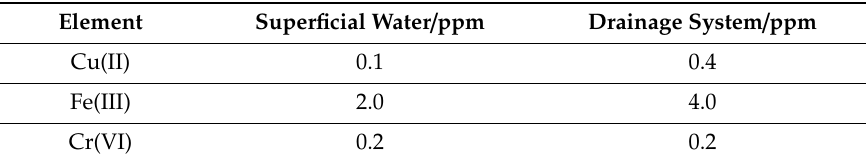
Table 3. Italian legal concentration limit for chromium (VI), iron, and copper for disposal in both superficial water and drainage systems. (All. 5, P. Terza, D. Lgs n.152 del